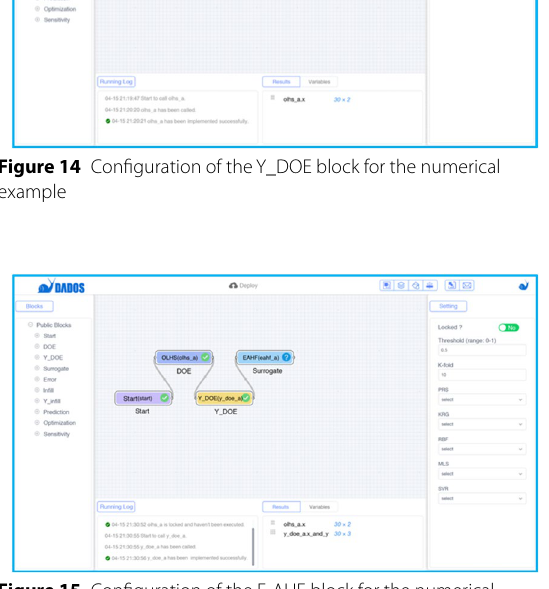
Figure 15 Configuration of the E-AHF block for the numerical example